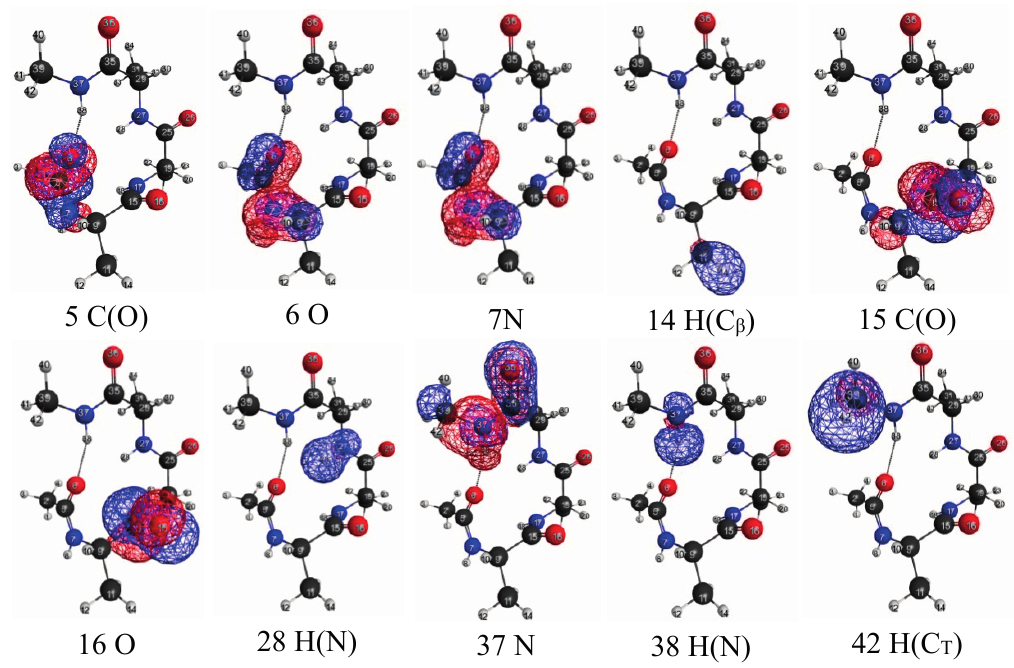
Figure 11. Isosurfaces of linear response functions for the perturbations on atomic sites. ( ) v 0.01 δρ δ = r and 0.01 = − are indicated as blue and red surfaces, respectively. For X carbons and hydrogens, we indicate the atomic types as follows. H(C T ) = H of the terminal methyl group. H(C α ) = H in the amide plane. H(C β ) = H of the methyl residue. C β , and C(0) are β carbon and carbon of the carbonyl group,